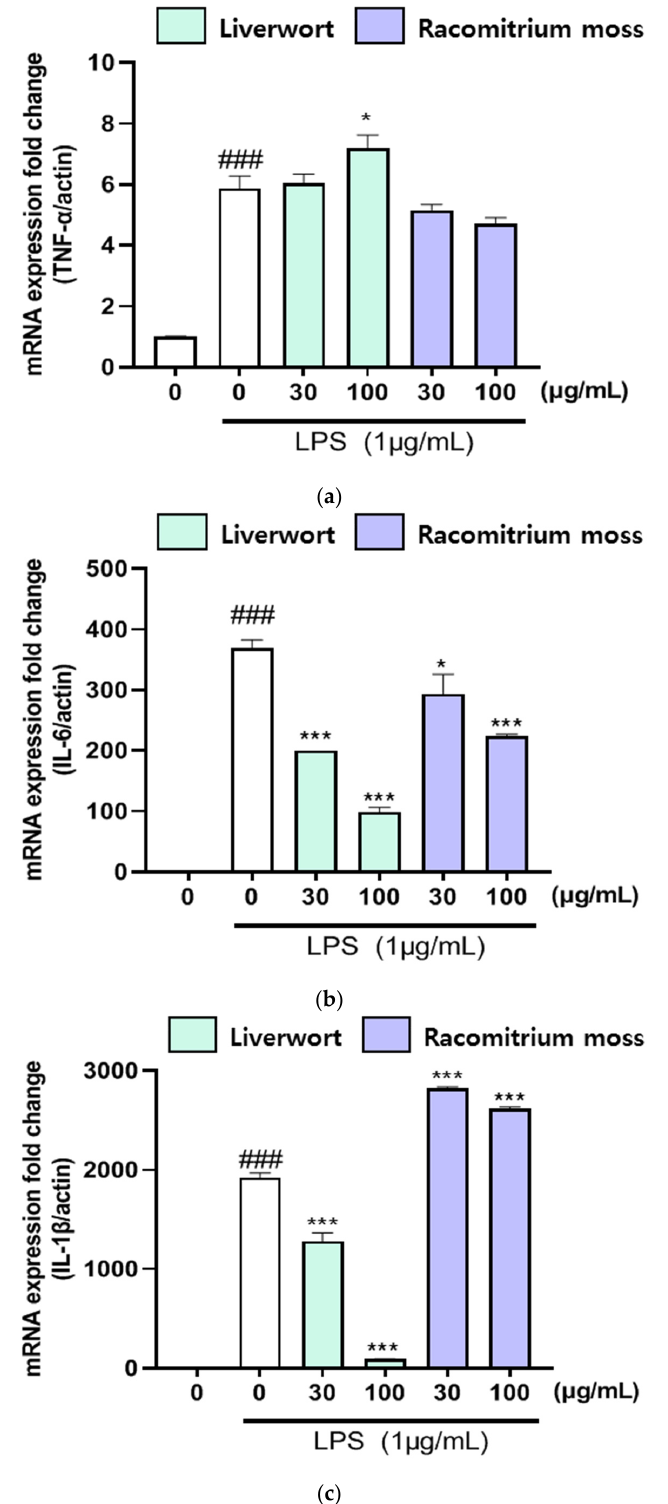
Figure 5. The effect of methanol extract of liverwort and Racomitrium moss on mRNA expressions of TNF- α , IL-6, and IL-1 β in LPS-stimulated HaCaT cells. ( a ) mRNA expression of TNF- α ; ( b ) mRNA expression of IL-6; ( c ) mRNA expression of IL-1 β . Values are mean of three replicate determinations ( n = 3) ± standard deviation. ### p < 0.001 vs. 1% MeOH alone, * p < 0.05, *** p < 0.001 vs. LPS